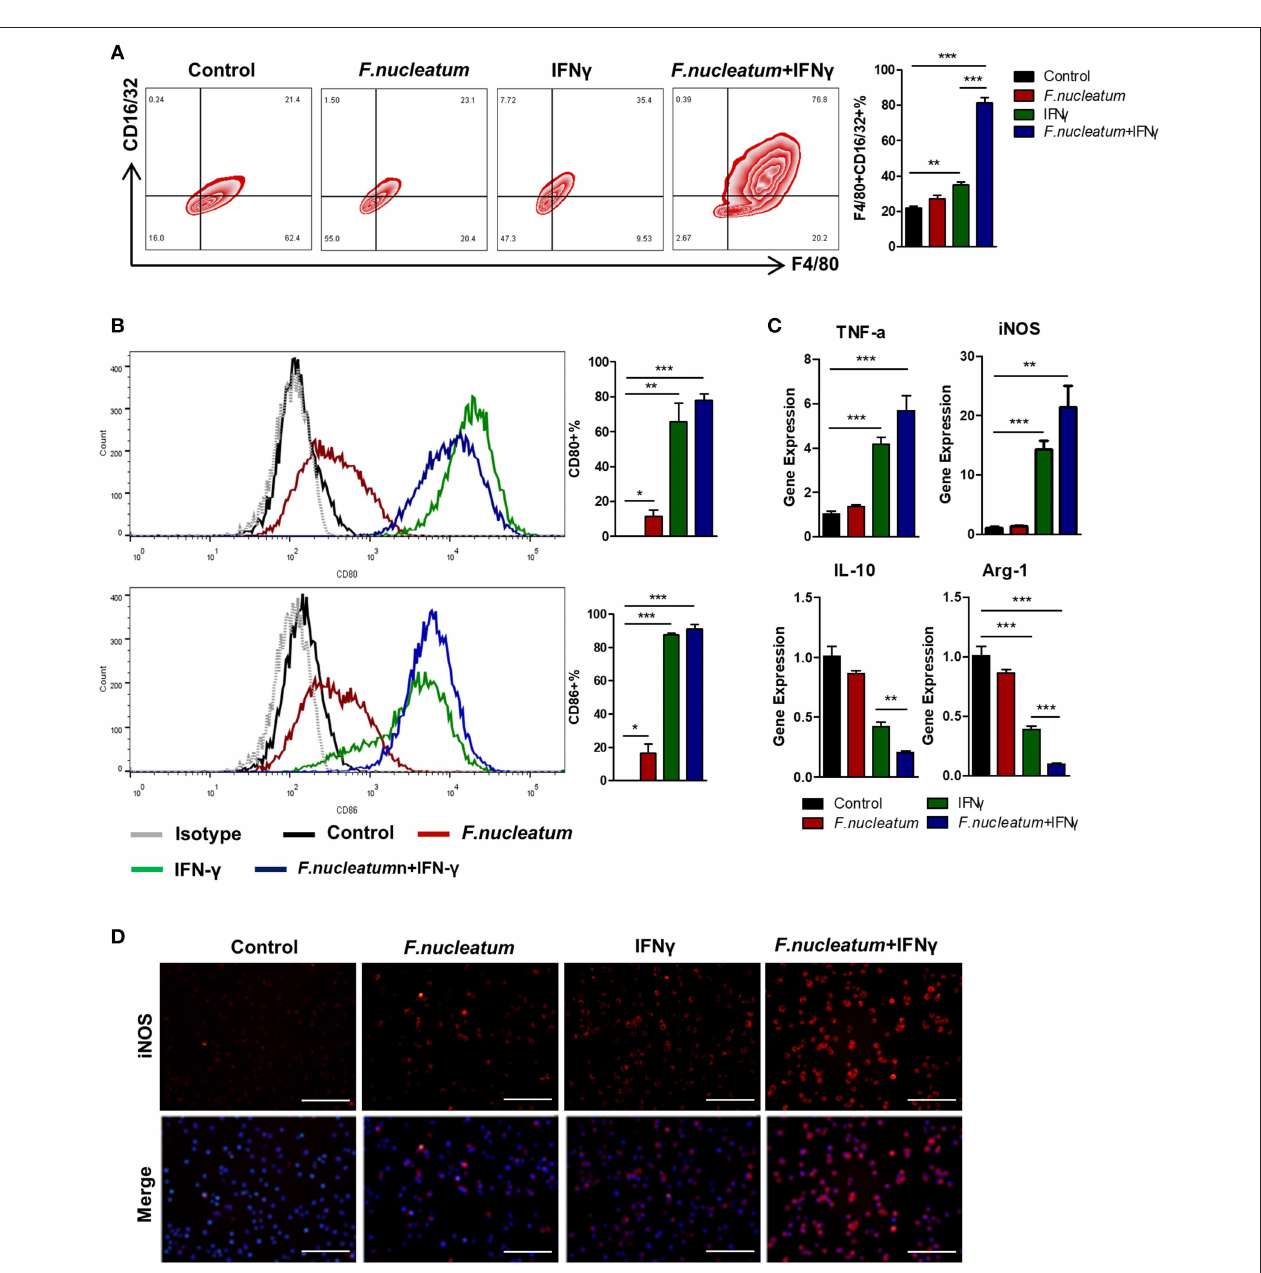
FIGURE 4 | F. nucleatum accelerates M1 macrophage polarization. (A) Flow cytometry staining of BMDMs for F4/80 and CD16/32. The frequency of cells positive for these markers was determined. (B) BMDMs surface molecular CD80 and CD86 expression in response to bacterial and/or IFN- γ treatment. (C) M1 markers: TNF- α and iNOS; M2 markers: IL-10 and Arg-1, as detected by qRT-PCR. (D) BMDMs were immunostained with iNOS (red) and DAPI (blue) from each group. Representative images are shown. Scale bars, 50 µ m. Each experiment was performed at least three times. Data are presented as means ± SD. * P < 0.05; ** P < 0.01; *** P < 0.001; Analysis of Variance (ANOVA) and Student’s t -test (two-tailed).